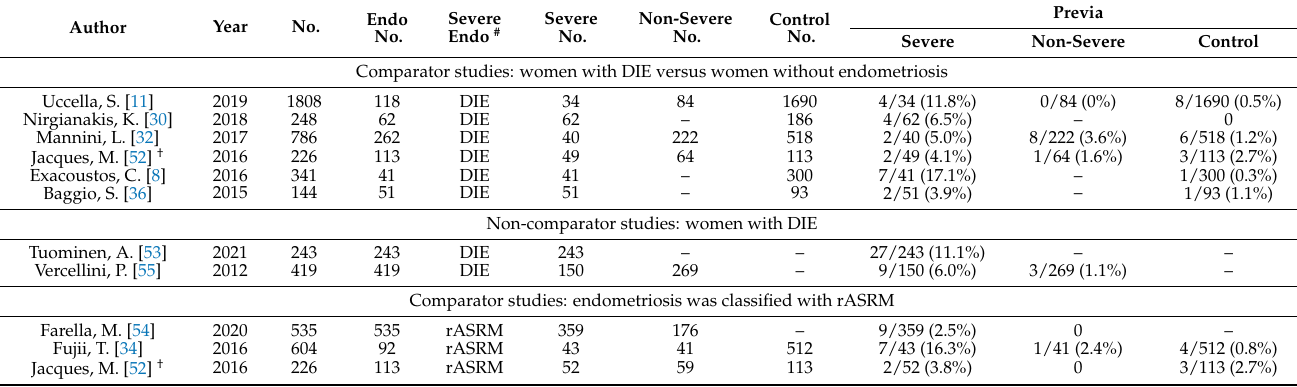
Table 2. Effect of severe and non-severe endometriosis on the prevalence of